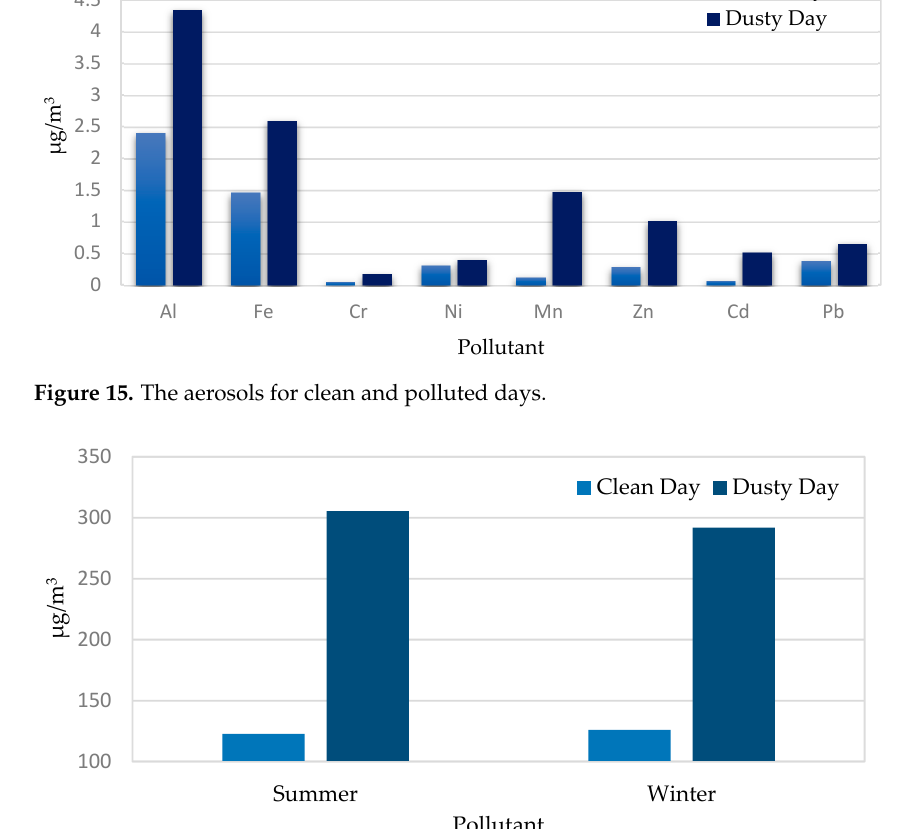
Figure 16. Concentration of particles in the summer and winter seasons.